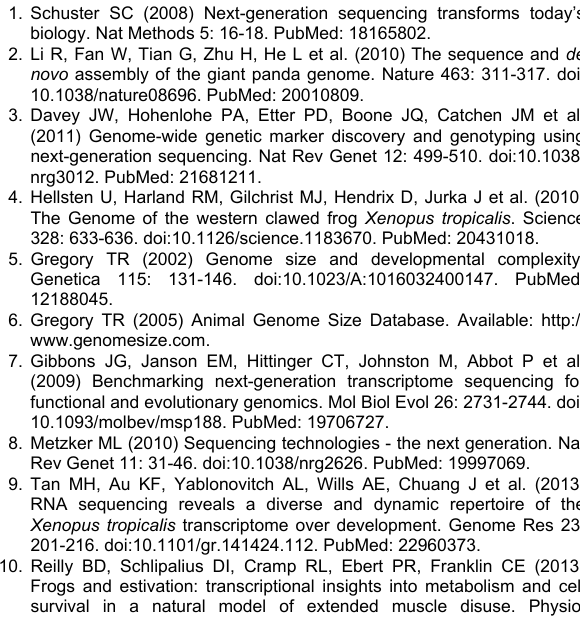
Table S3. SNPs in O. margaretae sequences. (XLSX) Table